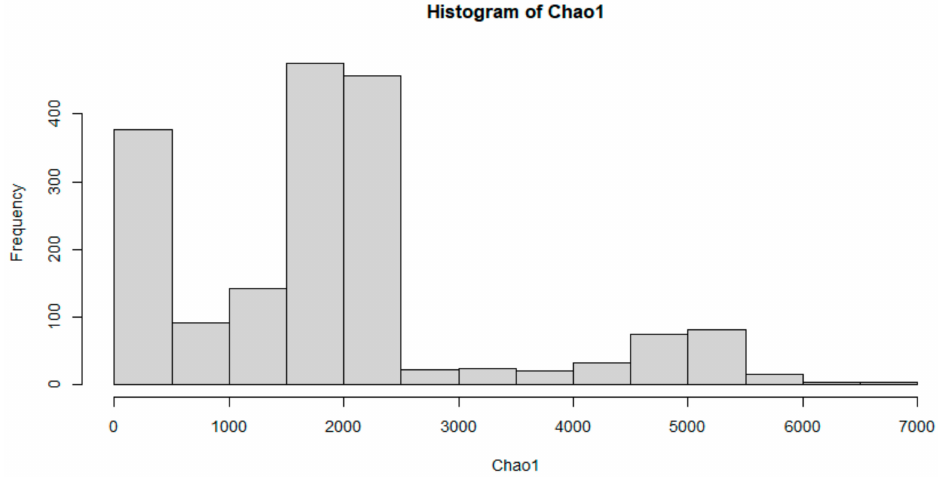
Figure 2. Chao1 index